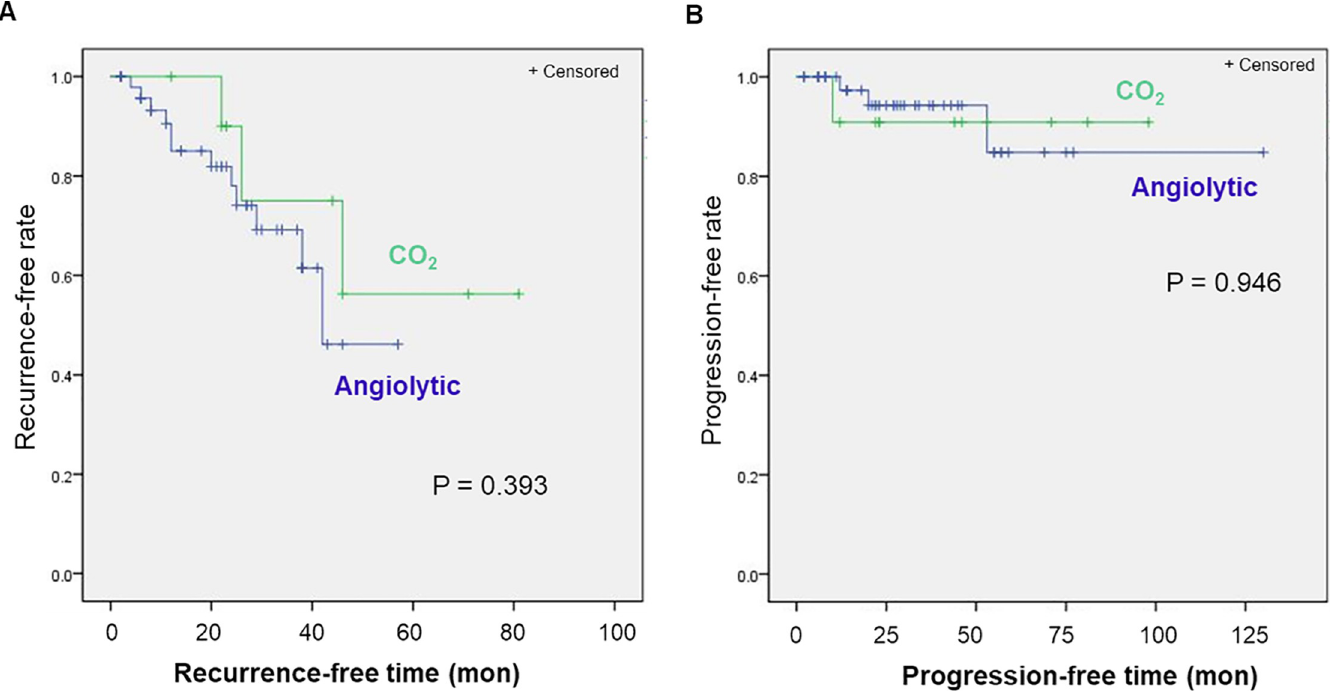
Fig 2. Kaplan-Meier Curve of (A) recurrence-free and (B) progression-free rate.